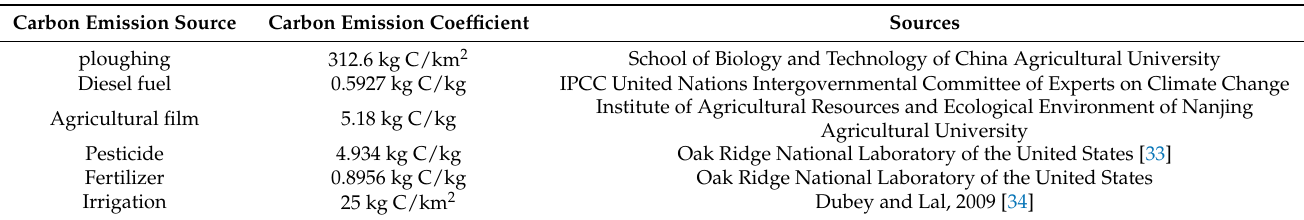
Table 3. Carbon emission coefficient and